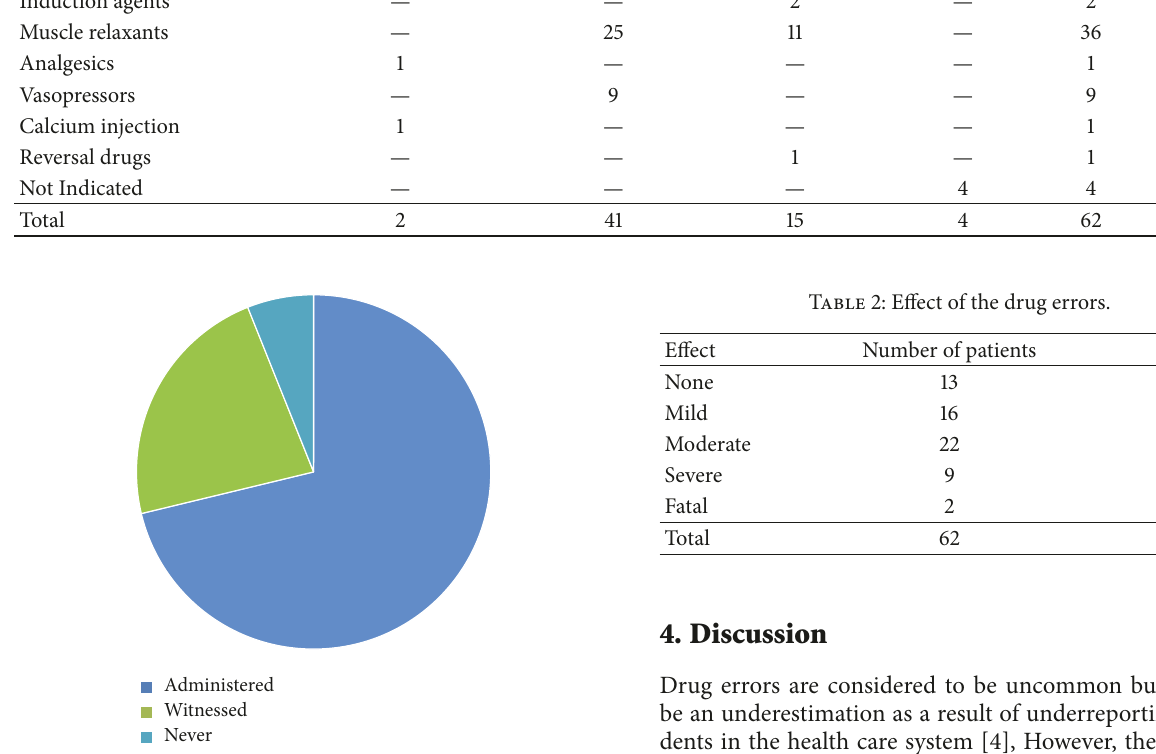
Figure 1: Incidence of drug errors.